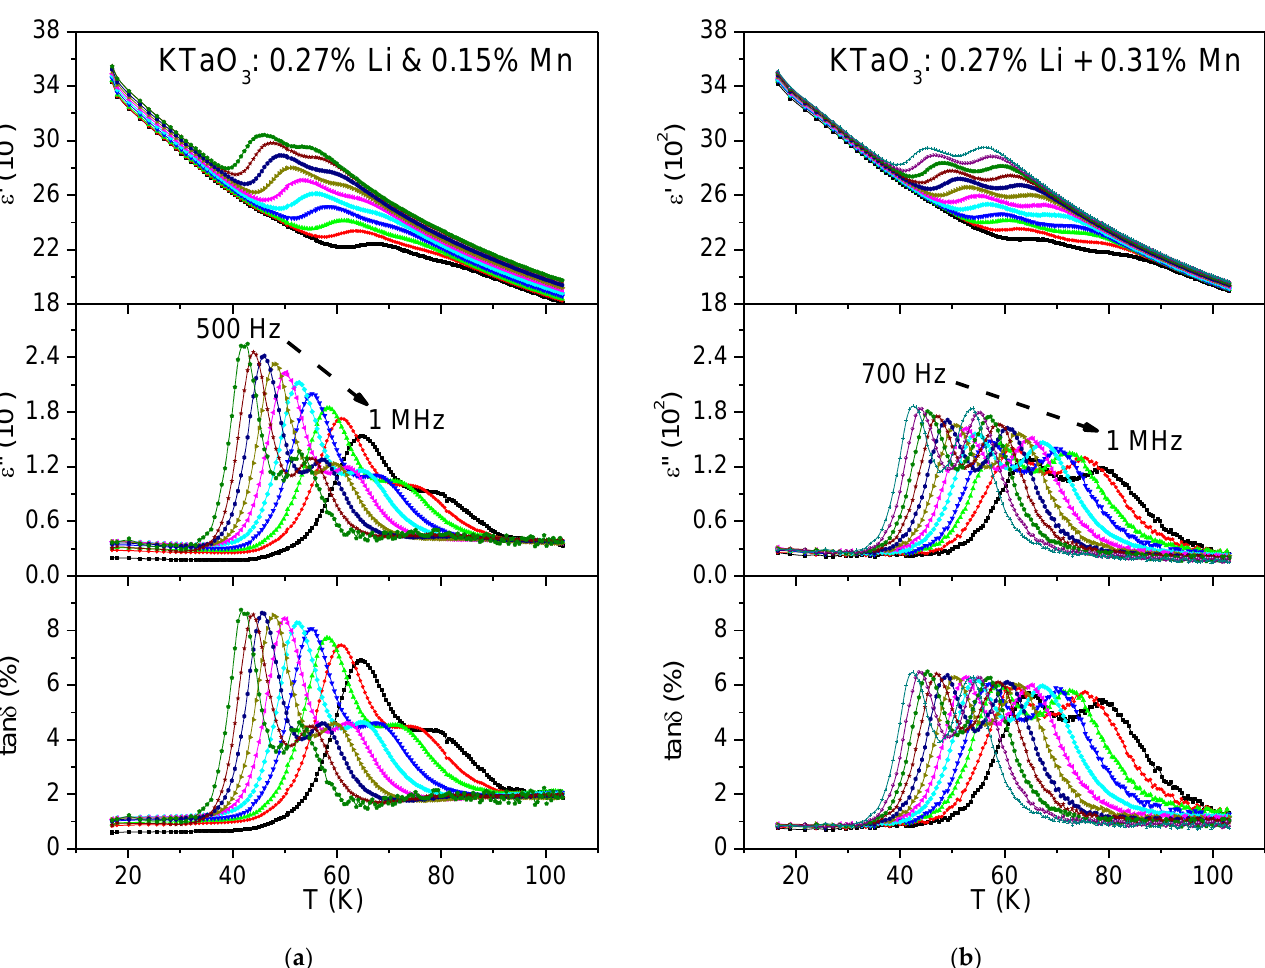
Figure 2. Real ε ’ ( top panels ) and imaginary ε ’’ ( middle panels ) parts of the dielectric permittivity and dissipation factor tanδ ( bottom panels ) of KTaO 3 : 0.27% Li + 0.15% Mn ( a ) and KTaO 3 : 0.27% Li + 0.31% Mn ( b ) single crystals as a function of temperature T at different frequencies from 500 Hz to 1 MHz.